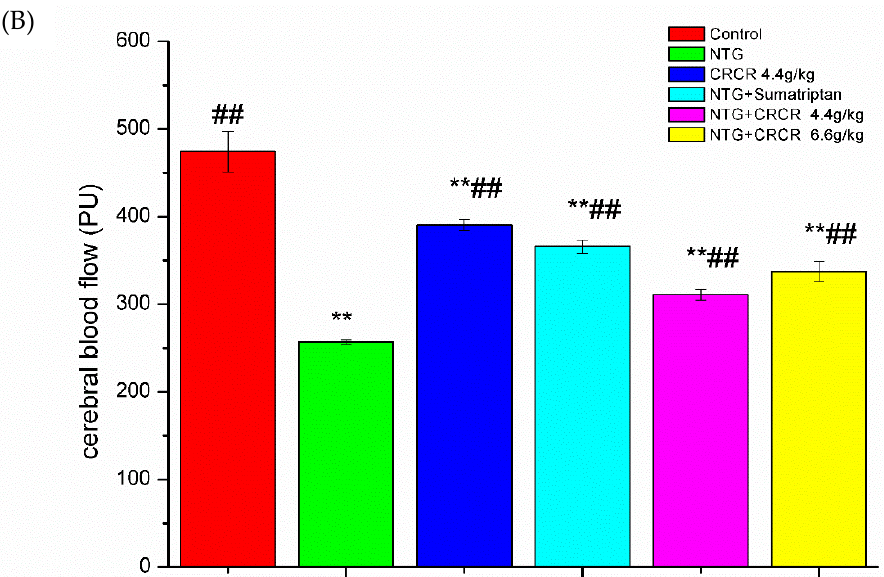
Figure 1. E ff ects of CRCR on cerebral blood flow. ( A ) Laser scanning images of cerebral blood flow in the cortex. ( B ) The mean cerebral blood flow values. Data are expressed as mean ± S.E. * p < 0.05, ** p < 0.01 vs. control group, # p < 0.05, ## p < 0.01 vs. NTG group.